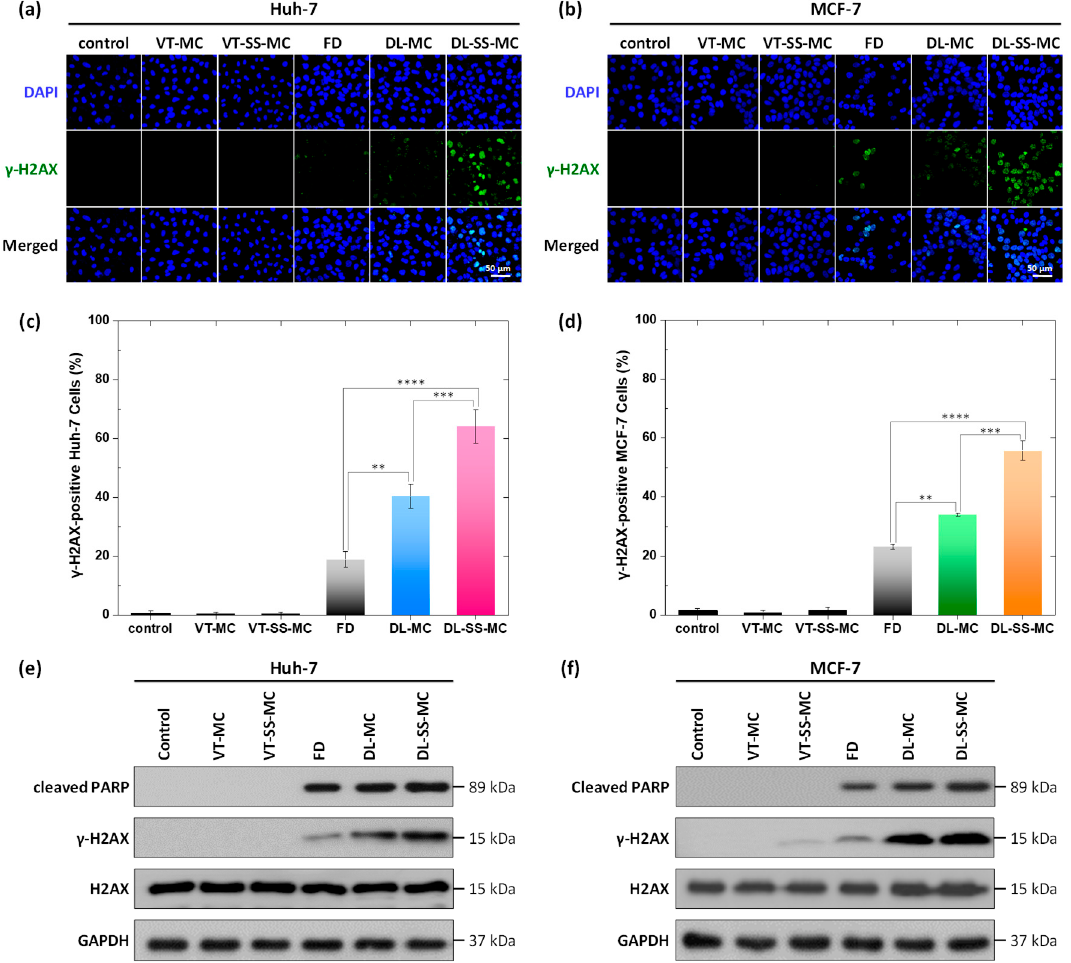
Figure 6. Huh-7 and MCF-7 cells were treated with empty vitamicelles (VT-MC, VT-SS-MC), DOX-loaded vitamicelles (DL-MC, DL-SS-MC), or FD for 24 h. ( a , b ) Fluorescence microscopy images of both cancer cell lines. Blue and green fluorescence represent cell nuclei (DAPI) and a marker of DNA double-strand breaks ( γ -H2AX), respectively. Scale bar = 50 µ m. ( c , d ) Number of γ -H2AX-positive cancer cells. Data are presented as the mean ± SD: ** p < 0.01, *** p < 0.001, **** p < 0.0001. ( e , f ) Western blot analysis of PARP, γ -H2AX, and H2AX expression in both cancer cell lines after treatment. GAPDH served as a loading